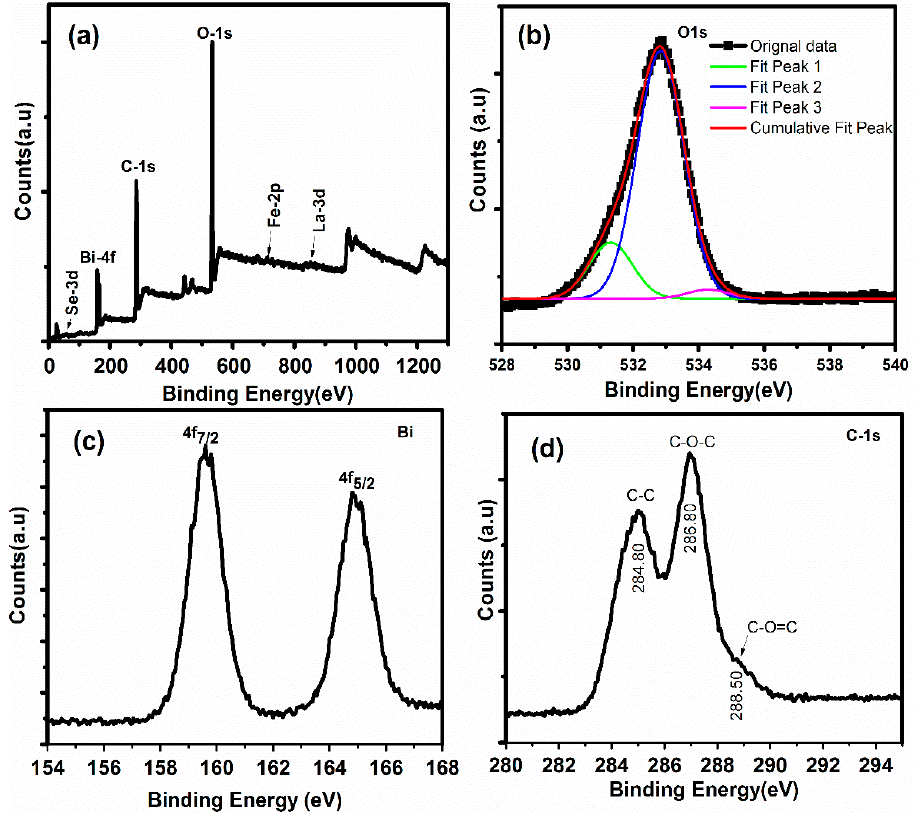
Figure 3. X-ray photoelectron spectroscopy (XPS) spectra of LBFSe50–G: (a) Survey spectra, (b) oxygen-1s, (c) Bismuth-4f, and (d) carbon-1s. ( b ) oxygen-1s, ( c ) Bismuth-4f, and ( d )